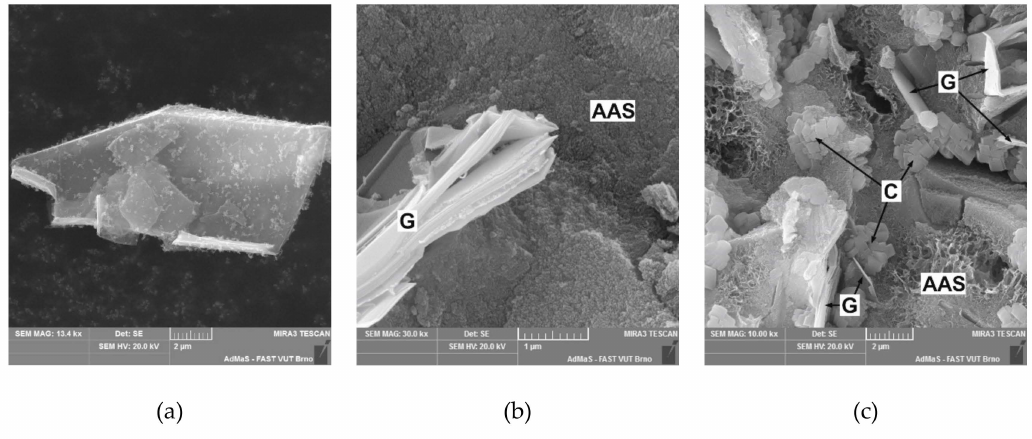
Figure 15. Details of microstructural features: ( a ) Shape of single graphite particle; ( b ) lamellar structure of graphite particle in the AAS matrix; ( c ) solid foam in the structure of AAS composite with 30 wt% of graphite. (AAS—alkali-activated slag matrix; G—graphite; C—calcium